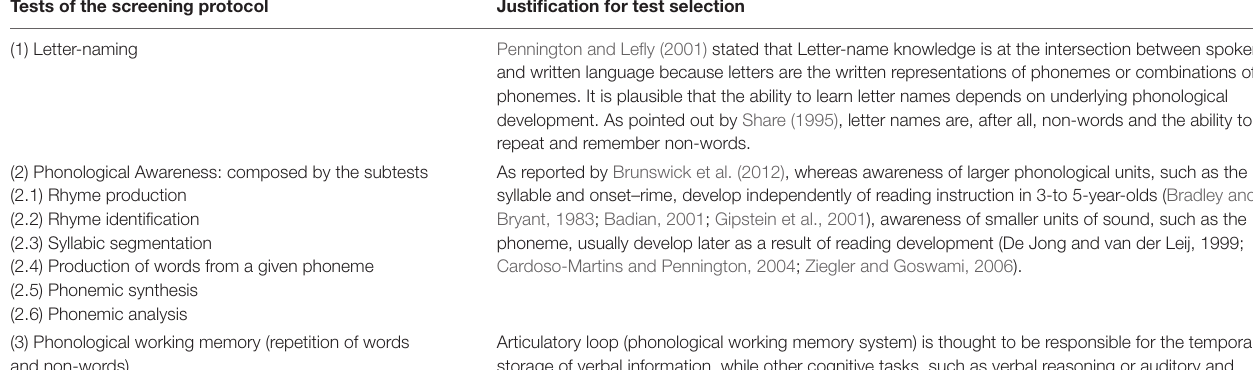
TABLE 1 | List of variables and justification for the development of the screening protocol for early identification of children at risk for dyslexia (Capellini et al., 2017). Tests of the screening protocol Justification for test